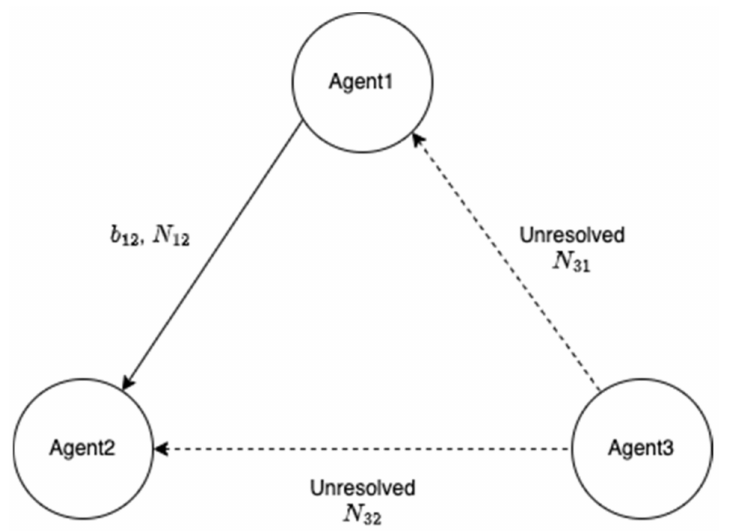
Figure 3. There are three agents, wherein agent 1 and agent 2 have correctly resolved integer ambiguities. The rest of the integer ambiguities need to be